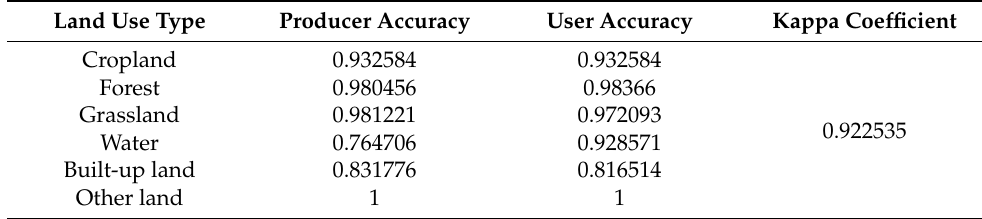
Table 5. Accuracy of land use change